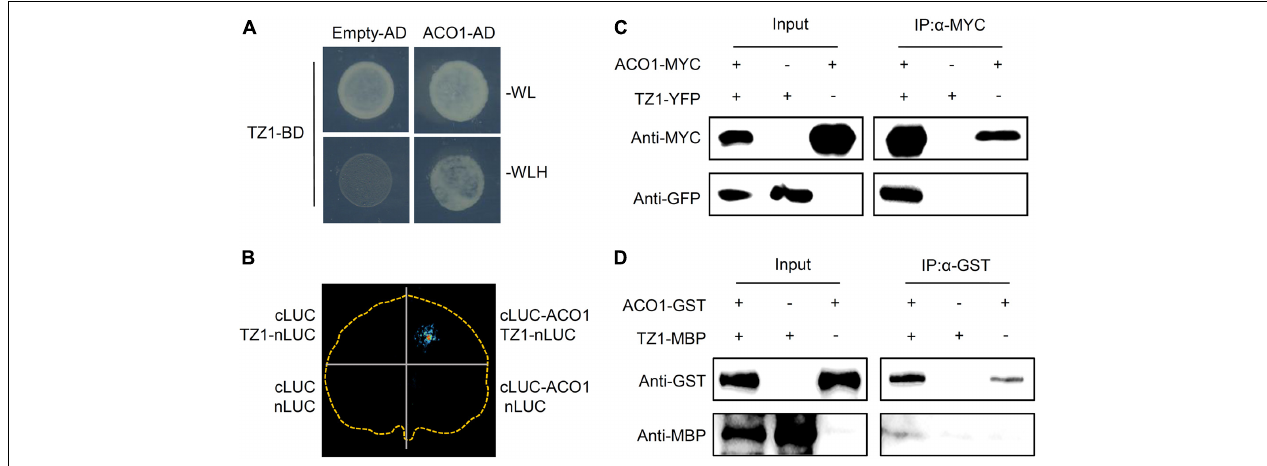
FIGURE 4 | Transition zone1 interacts with ACO1. (A) Transition zone1 specifically interacts with aconitase1 (ACO1) in yeast. TZ1 was used as bait, the C-terminal of ACO1 was used as prey. Empty-AD was co-transformed as negative control. (B) Luciferase complementary imaging (LCI) analysis of interaction between TZ1 and ACO1. The N-terminal half of luciferase (nLUC) was fused to TZ1, and the C-terminal half of luciferase (cLUC) was fused to ACO1 (634–899 aa), and different construct combinations were co-expressed in N. benthamiana . LCI, luciferase complementation imaging. (C) In vivo Co-IP assay of TZ1 interaction with ACO1. ACO1-MYC was co-expressed with TZ1-YFP in Arabidopsis mesophyll cell protoplast. Protein extracts (Input) were immuno-precipitated with anti-MYC antibody (IP). Immunoblots were developed with anti-GFP antibody to detect TZ1 and with anti-MYC antibody to detect ACO1. (D) Western blotting assay of the GST pull down assay of ACO1-GST and TZ1-MBP.